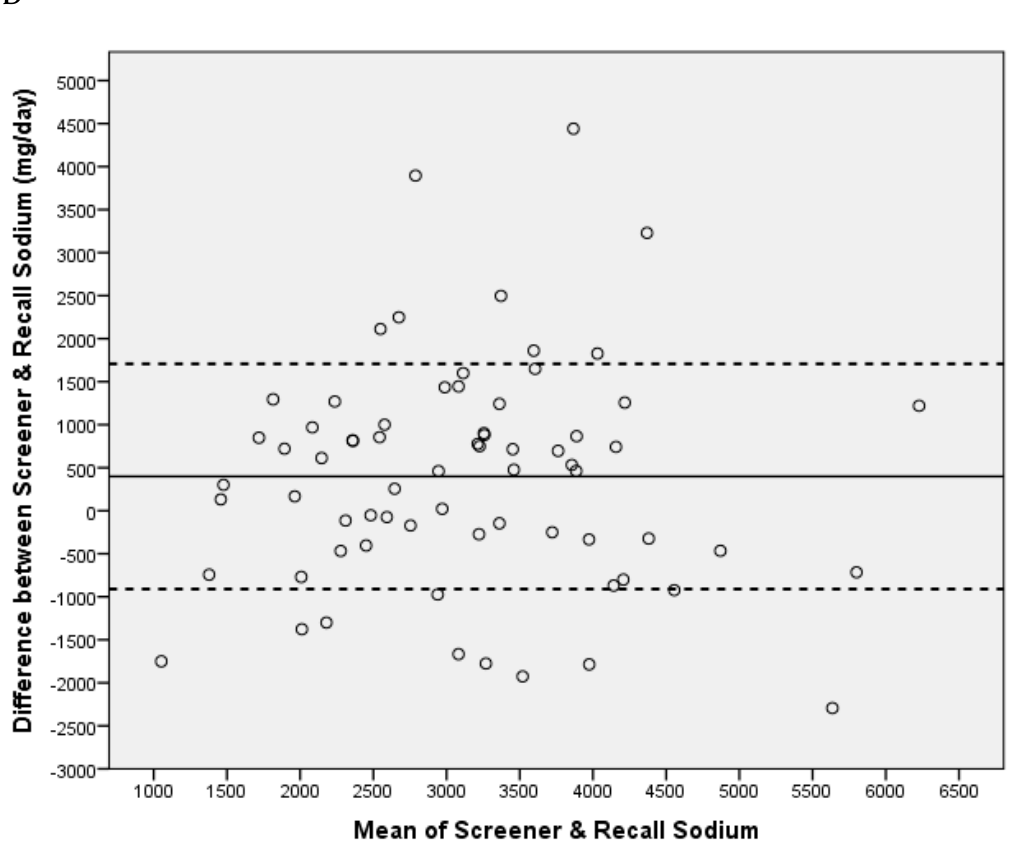
Figure 1. A Bland–Altman graph of bias (mean difference) between the predicted sodium estimates derived from the Sodium Screener (SS©) and dietary sodium intake from the average of three recalls in the RD study ( A ) and in the SHoPPER ( B ). The dashed lines represent limits of agreement ( ± 2 SD). Predicted intakes from the SS© scores underestimated daily sodium intake by 550 mg ( A ) and overestimated daily sodium intake by 399 mg ( B ). Bias did not appear to vary by the amount consumed.